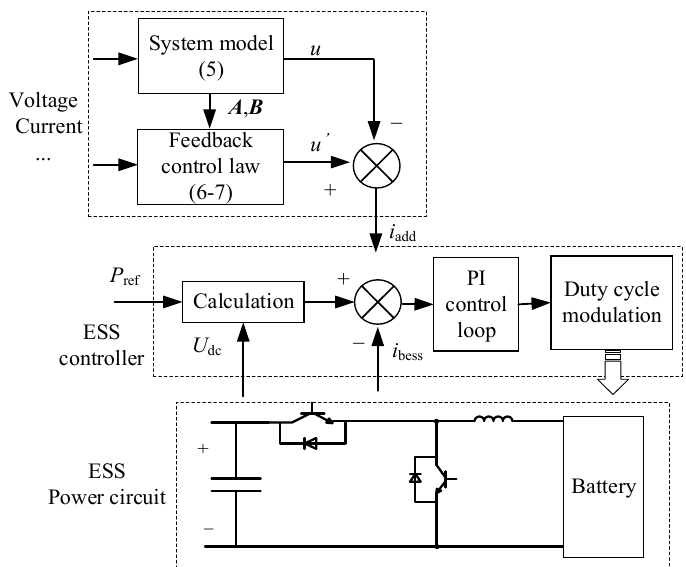
Figure 7. Additional control strategy.